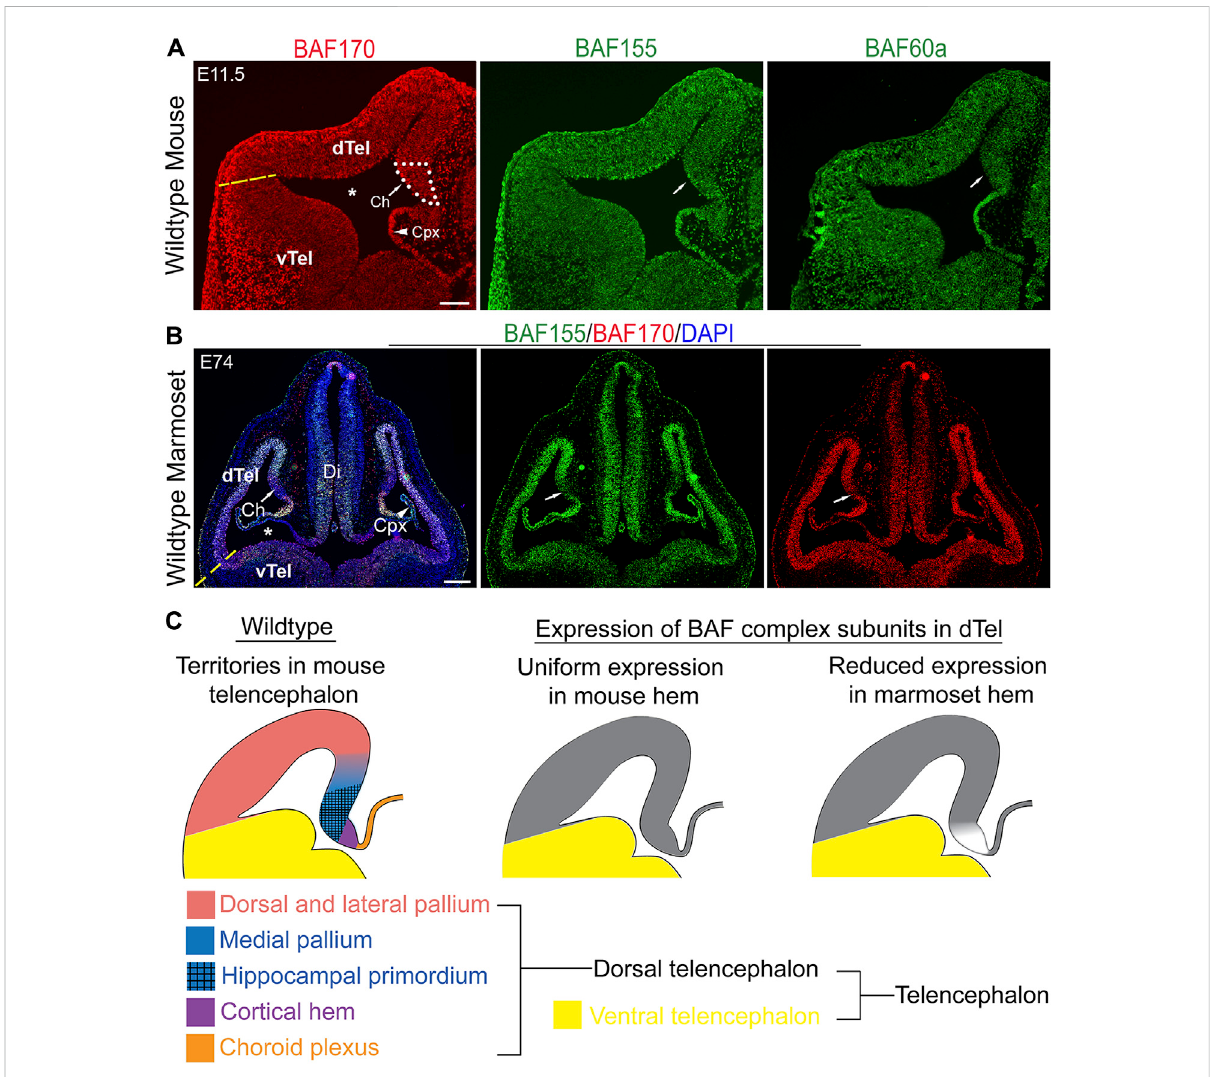
FIGURE 1 Comparative expression analysis suggests arole for BAFcomplexinmammalian forebrain patterning. (A) Imagesshowinghemi-sections ofthe E11.5 wild-type mouse telencephalon immunostained for the BAF complex subunits BAF155, BAF170, and BAF60a. An approximation of the border between the dorsal telencephalon and ventral telencephalon is indicated with a yellow dashed line. Medial telencephalic territories, i.e., the cortical hem and choroid plexus, are shown. (B) Images of the marmoset whole head showing immunostaining of the E74 telencephalon with BAF155, BAF170 antibodies. Arrow points to the cortical hem area. The lateral ventricle is indicated by an asterisk. Yellow dashed line indicates an approximation of the dorsal and ventral telencephalon boundary. (C) Schematics showing territorial designation of the mouse dorsal telencephalon (right panel), and the generalized expression of BAF complex subunits in the mouse (middle panel) and marmoset (left panel) dorsal